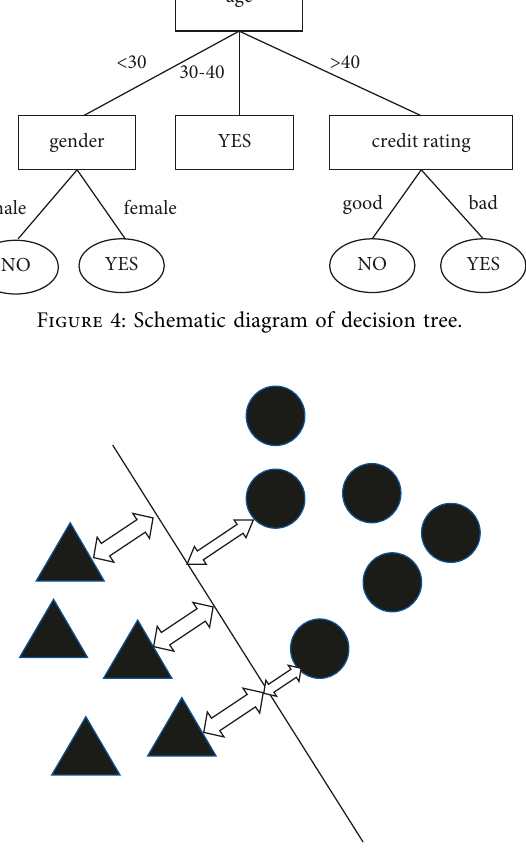
Figure 5: Schematic diagram of